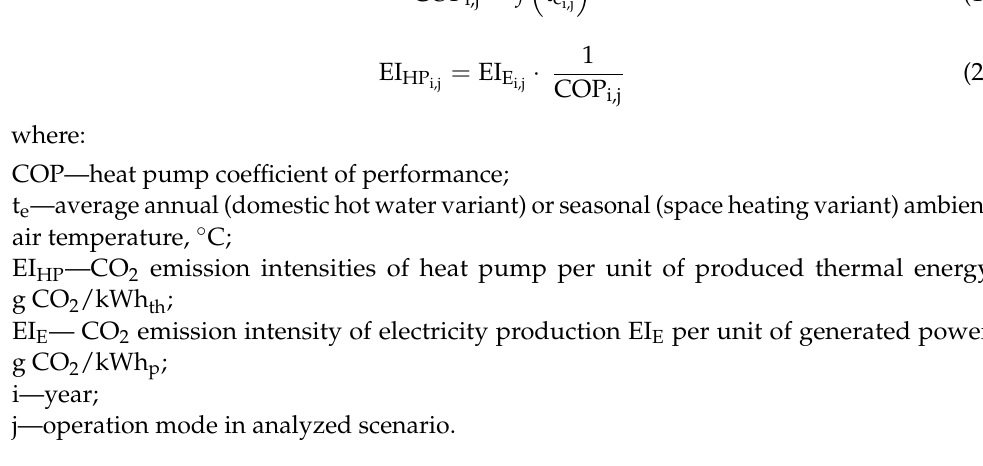
2 emission intensities of heat